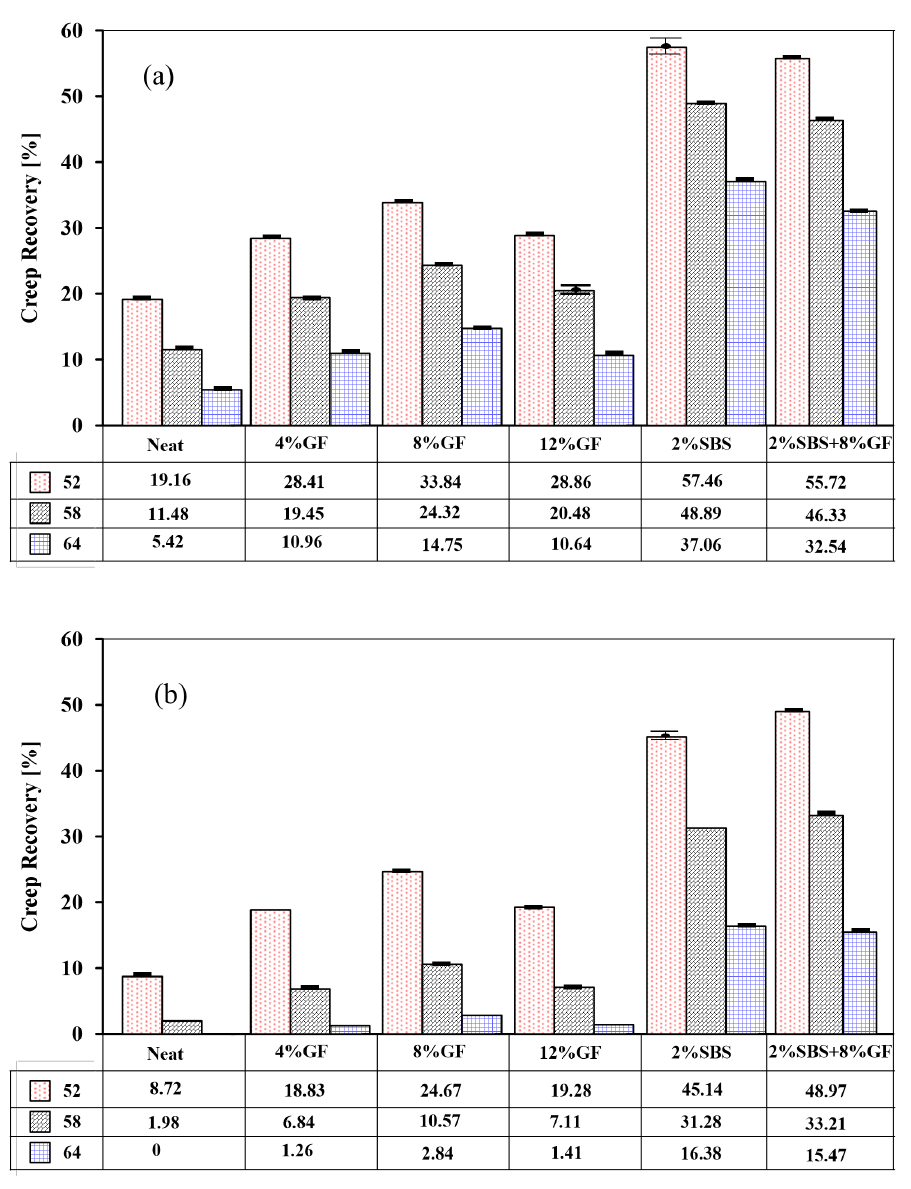
Figure 8. Creep recovery of neat and modified asphalt binders at ( a ) 0.1 kPa and ( b ) 3.2 kPa. Comparing the hybrid binder to the binder with the closest non-recoverable creep compliance strain, which was 2%SBS, the hybrid binder performed at 54% and 59% lower non-recoverable creep strain with p -values of 6.5 × 10 − 4 and 8.7 × 10 − 4 at 0.1 and 3.2 kPa, respectively. In addition, it can be observed that the 2%SBS binder showed a 17% reduc- tion in non-recoverable strain values compared to the 8%GF at the 0.1 kPa stress level ( p -value = 6.4 × 10 − 4 ) and an insignificant difference of 2% in the non-recoverable strain at the 3.2 kPa stress level ( p -value = 0.05). These observations are essential, considering that the 2%SBS binder showed similar strain recovery to the hybrid binder at 3.2 kPa, for various temperatures, as shown in Figure 8. This reconfirms that the hybrid modification with GF and SBS led to superior strain recovery compared to the GF or SBS